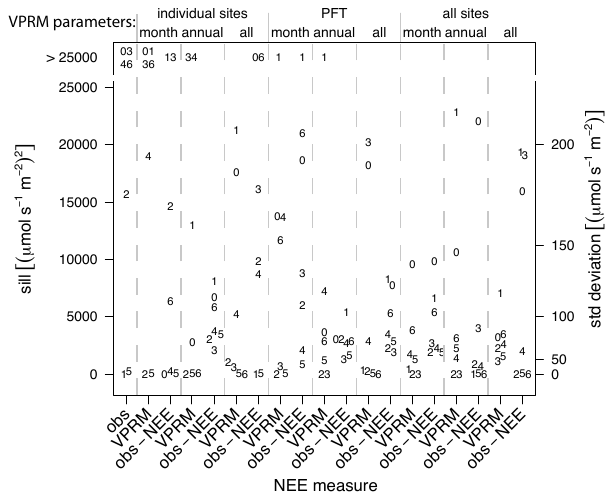
Fig. 7. As Fig. 6, but displaying semivariogram sill